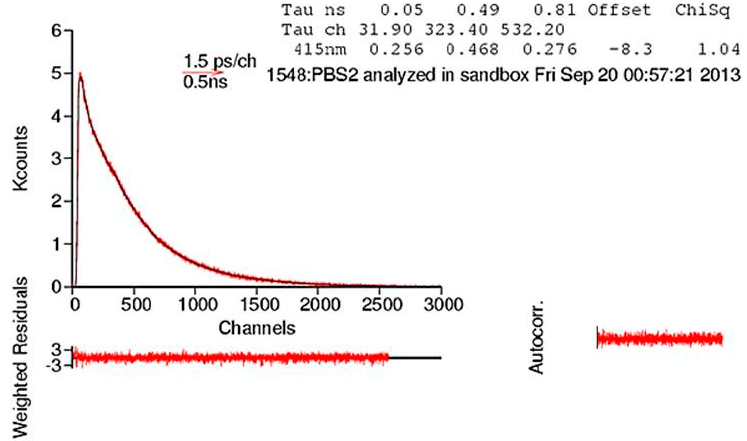
Figure 4. Fluorescence emission decay of PBS-PFP2 at 415 nm in a 1:1 MeOH/H 2 O solution fitted to the sum of three exponentials. Weighted residuals (W.R., scale − 3 ≤ σ ≤ +3) and autocorrelation functions are also presented to show the quality of the fit. Table 2. Decay times and amplitudes in a 1:1 MeOH/H 2 O solution of PBS-PFP (6.84 × 10 − 5 M in terms of repeat unit), PBS-PFP2 (6.43 × 10 − 5 M in terms of repeat unit), and PBS-PFP3 (5.56 × 10 − 5 M in terms of repeat unit).